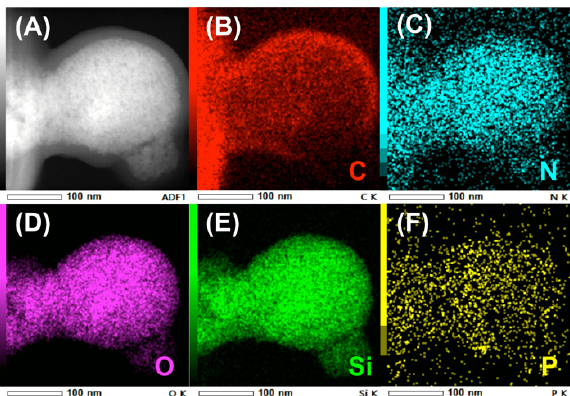
Figure 5. TEM elemental mapping of uf-P@m-SiO 2 . ( A ) the TEM image of uf-P@m-SiO 2 , ( B ) the C element mapping, ( C ) the N element mapping, ( D ) the O element mapping, ( E ) the Si element mapping ( F ) the P element mapping.